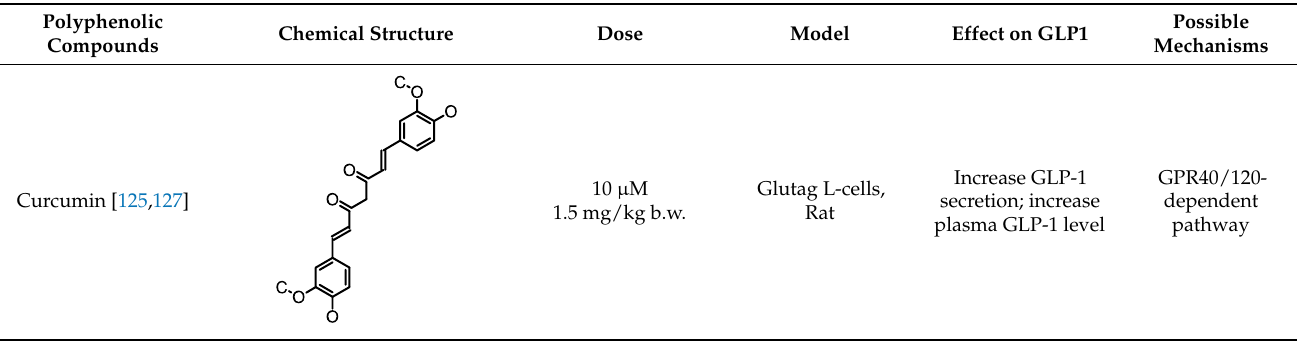
Table 1. Polyphenolic compounds that regulate GLP-1 secretion via G protein coupled receptor (GPCR)- or cAMP- mediated